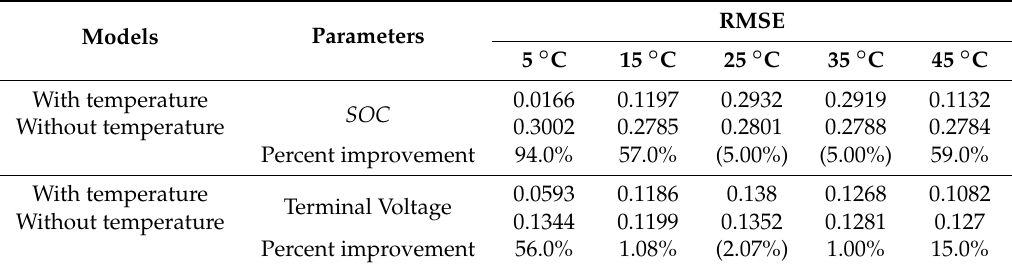
Table 3. RMSE comparison between the proposed model using EKF for SOC and terminal voltage estimation.